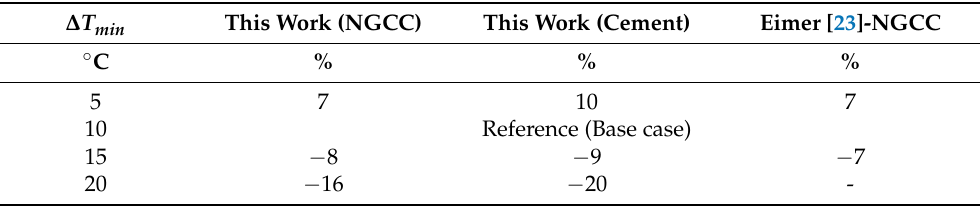
Table 9. Comparison of heat recovery in the lean/rich heat exchanger of the standard CO 2 capture